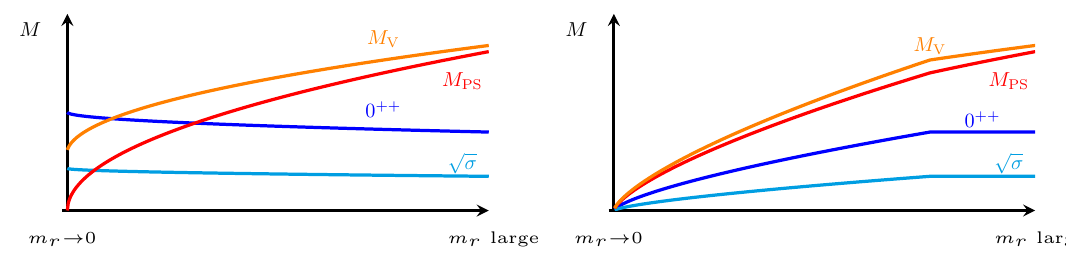
Figure 3 . Sketch of the mass spectrum as a function of the fermion mass m r for a QCD-like (left) and a IR conformal (right) scenario. Indicated are the masses of the pseudoscalar (PS) and vector (V) mesons, the scalar (0++) glueball and the square-root of the string tension (cid:27)